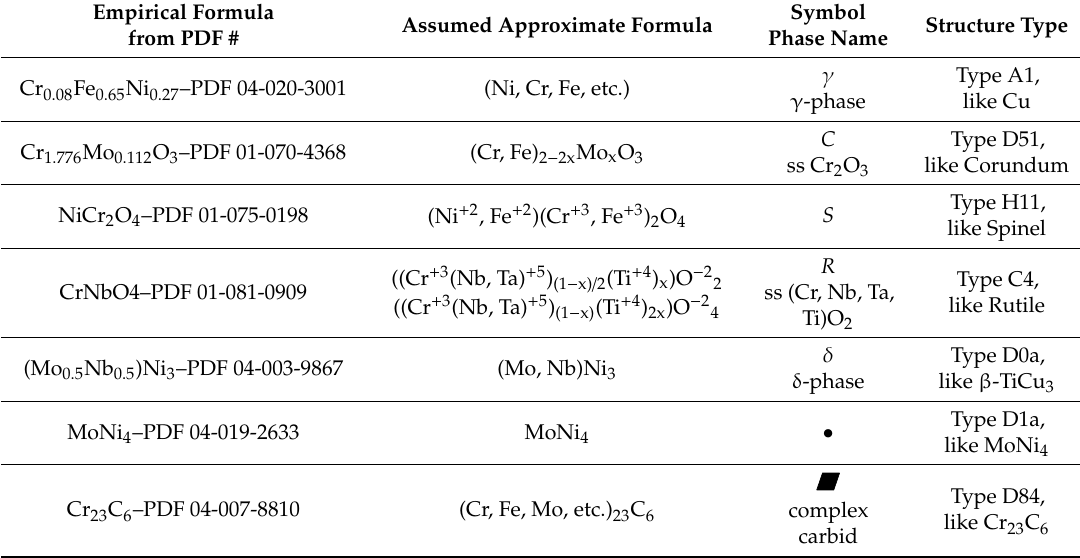
Table A1. Description of the phases identified using XRD in the analyzed oxidized samples. Empirical